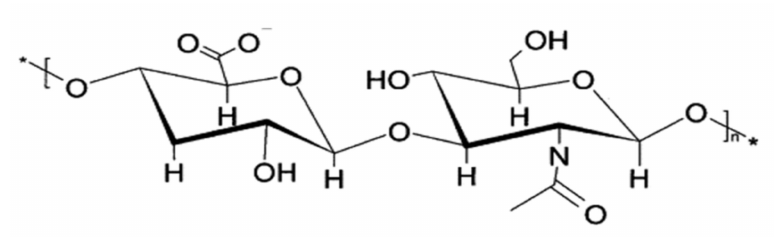
Figure 7. The backbone of the hyaluronan molecule, with the main constituents of D -glucuronic acid ( left ) connected via ester linkage to N -acetyl glucosamine ( right ). Reused with permission from Ward et al. [145]. Copyright © 2021 Elsevier Science B.V. All rights